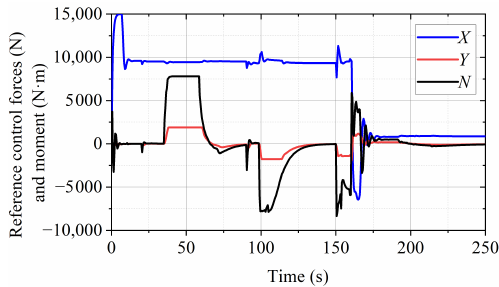
Figure 8. Reference control vectors in the zig-zag path